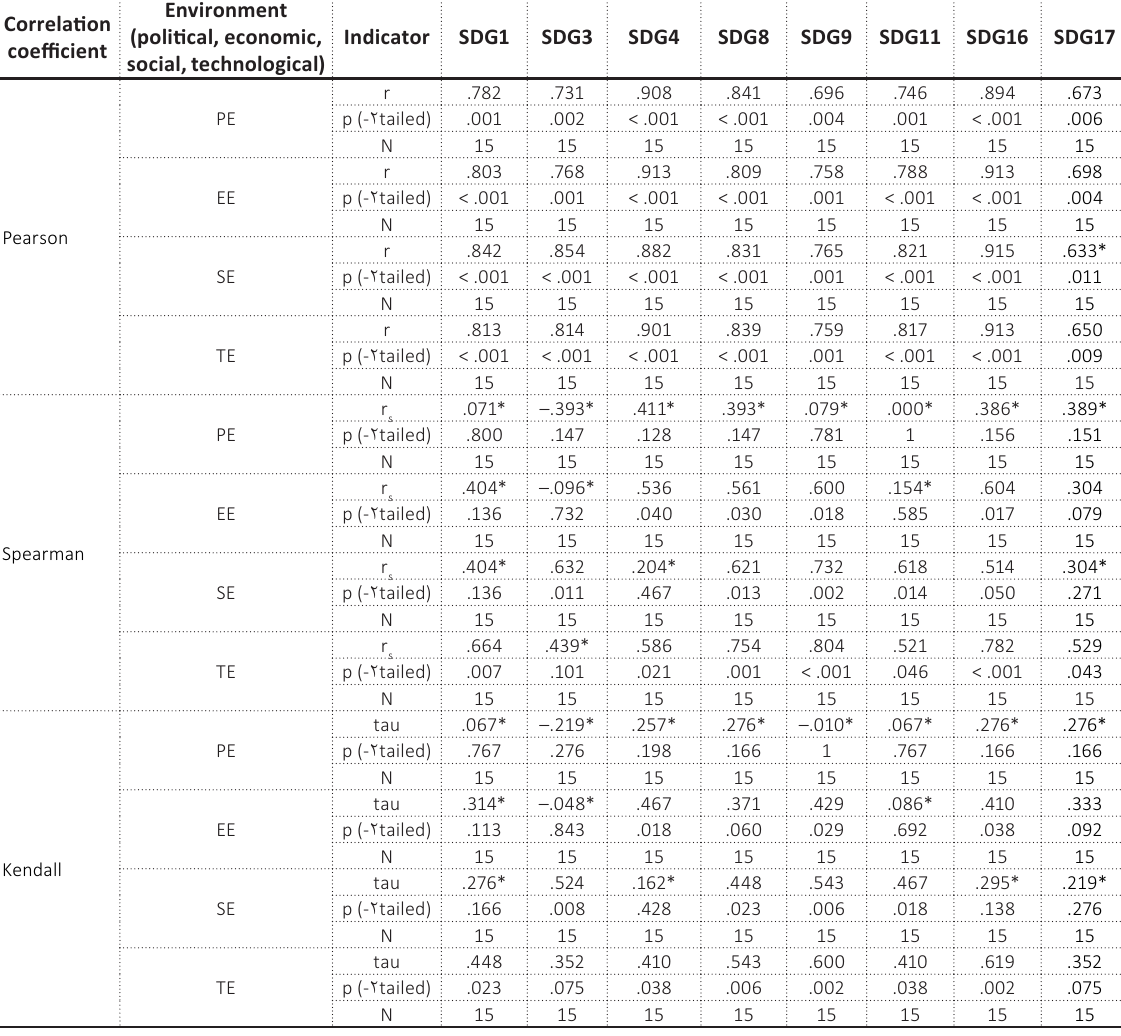
Table 5. Kendall, Pearson, and Spearman correlation coefficients measuring the strength of association between FinTech political, economic, social, technological environments and SDG scores